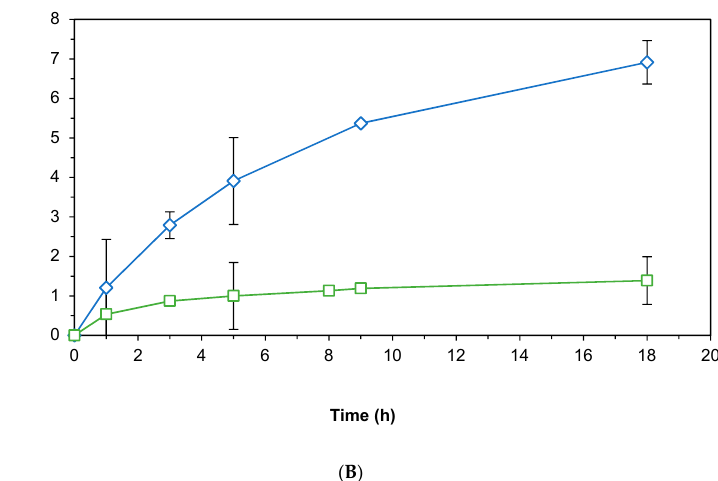
Figure 5. ( A ) Representative scheme of the HLADH-catalyzed reduction of 4-phenyl-2-butanone to enantioenriched 4-phenyl-2-butanol; ( B ) Time course of the reaction with NADH (blue diamonds) or BNAH + NAD (green squares). Reaction conditions: 100 mM KPi pH 7.0, 1 mL final volume, HLADH (2 U), [NADH] = 16.7 mM (blue diamonds), [BNAH] = 16.7 mM + [NAD] = 1 mM (green squares),